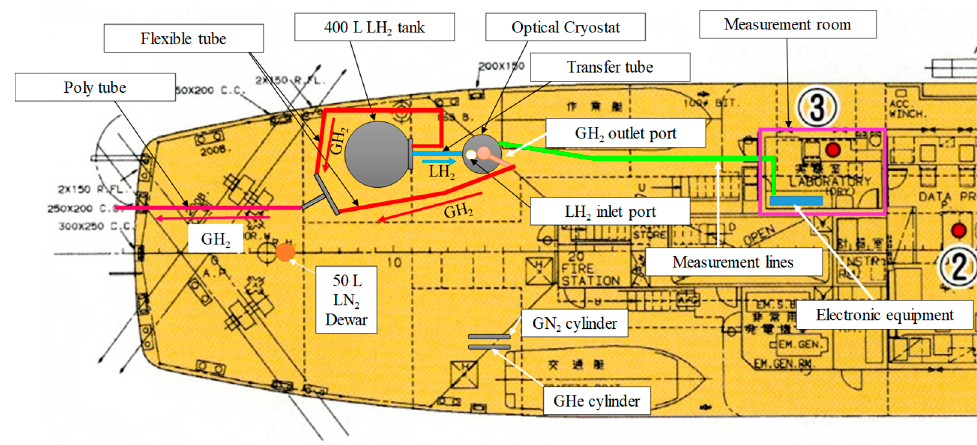
Figure 5. Setup of the experimental apparatus.